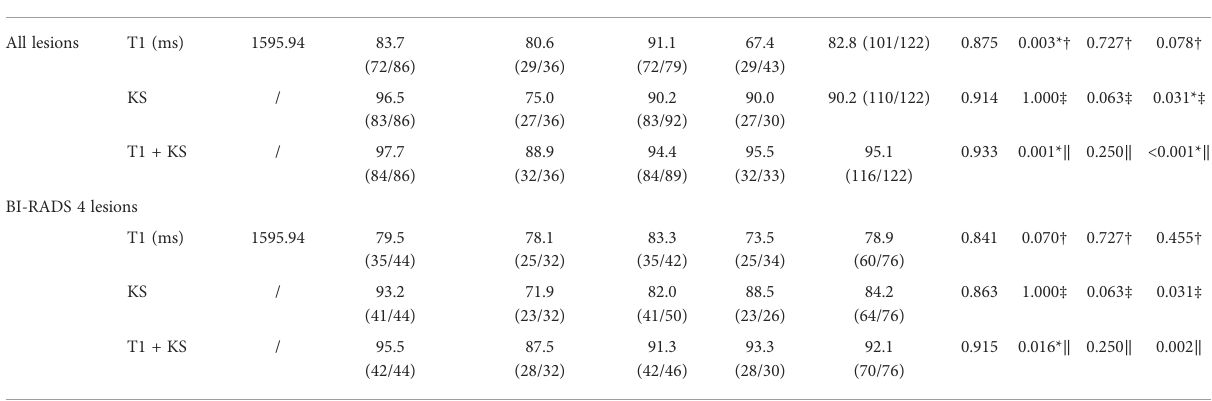
P a , P b , and P c values were calculated using the McNemar test to compare the differences in sensitivity, speci fi city, and accuracy, respectively. † P values (KS vs. T1); ‡ P values (KS vs. T1+KS); ‖ P values (T1 vs.